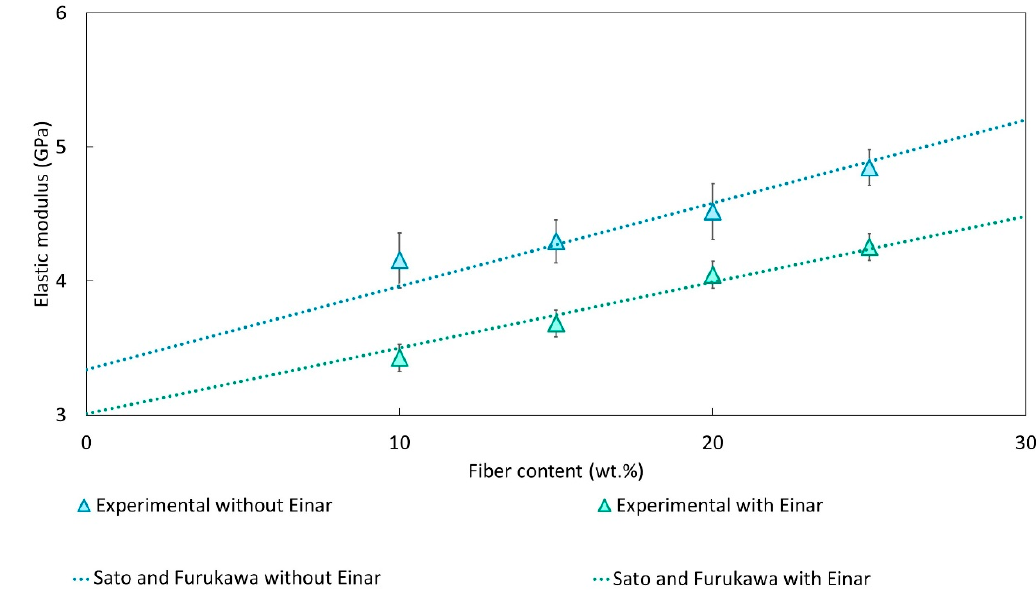
Figure 5. Comparison between the predicted elastic modulus obtained with the Sato and Furukawa model and the experimental data. Table 4. Values of the calculated parameter correlated to the fiber/matrix adhesion according to the Sato and Furukawa and Pukánszky models for the PLA/Arbocel composite system with and without Einar. Composite System